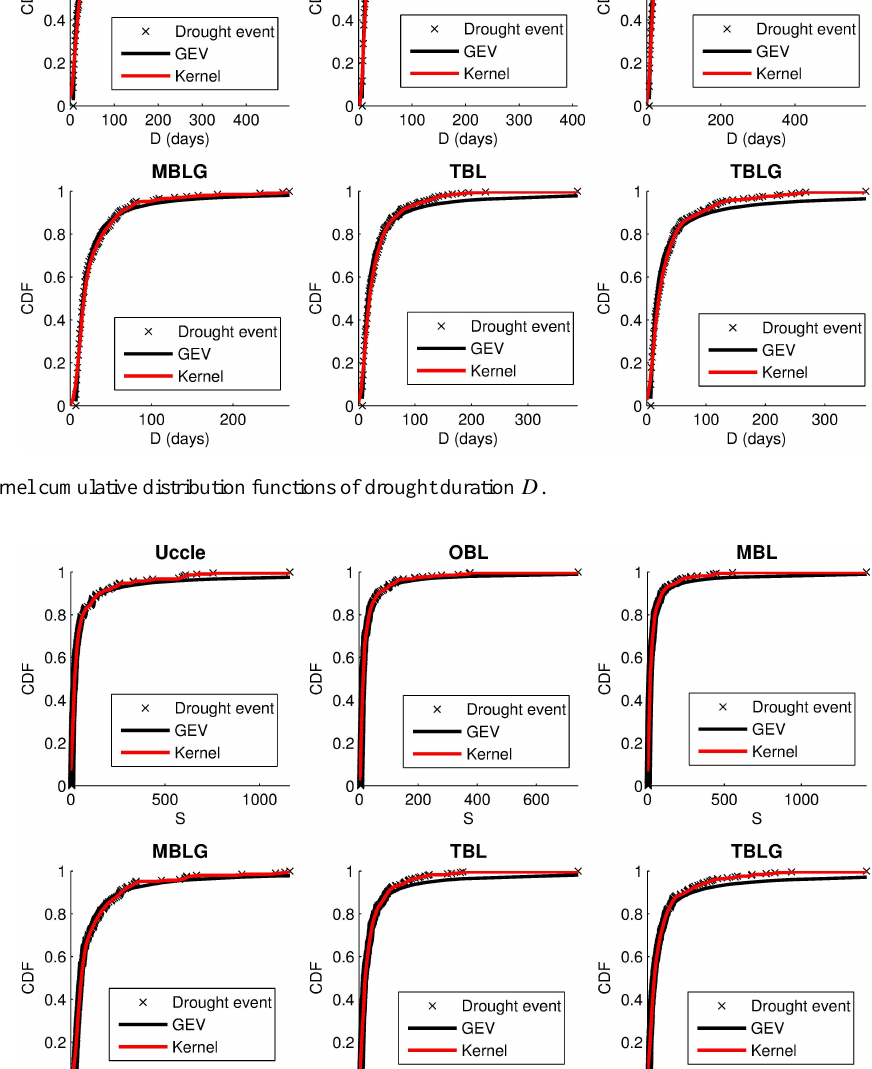
(red line) is better in simulating the extreme values while the GEV (black line) overestimates the